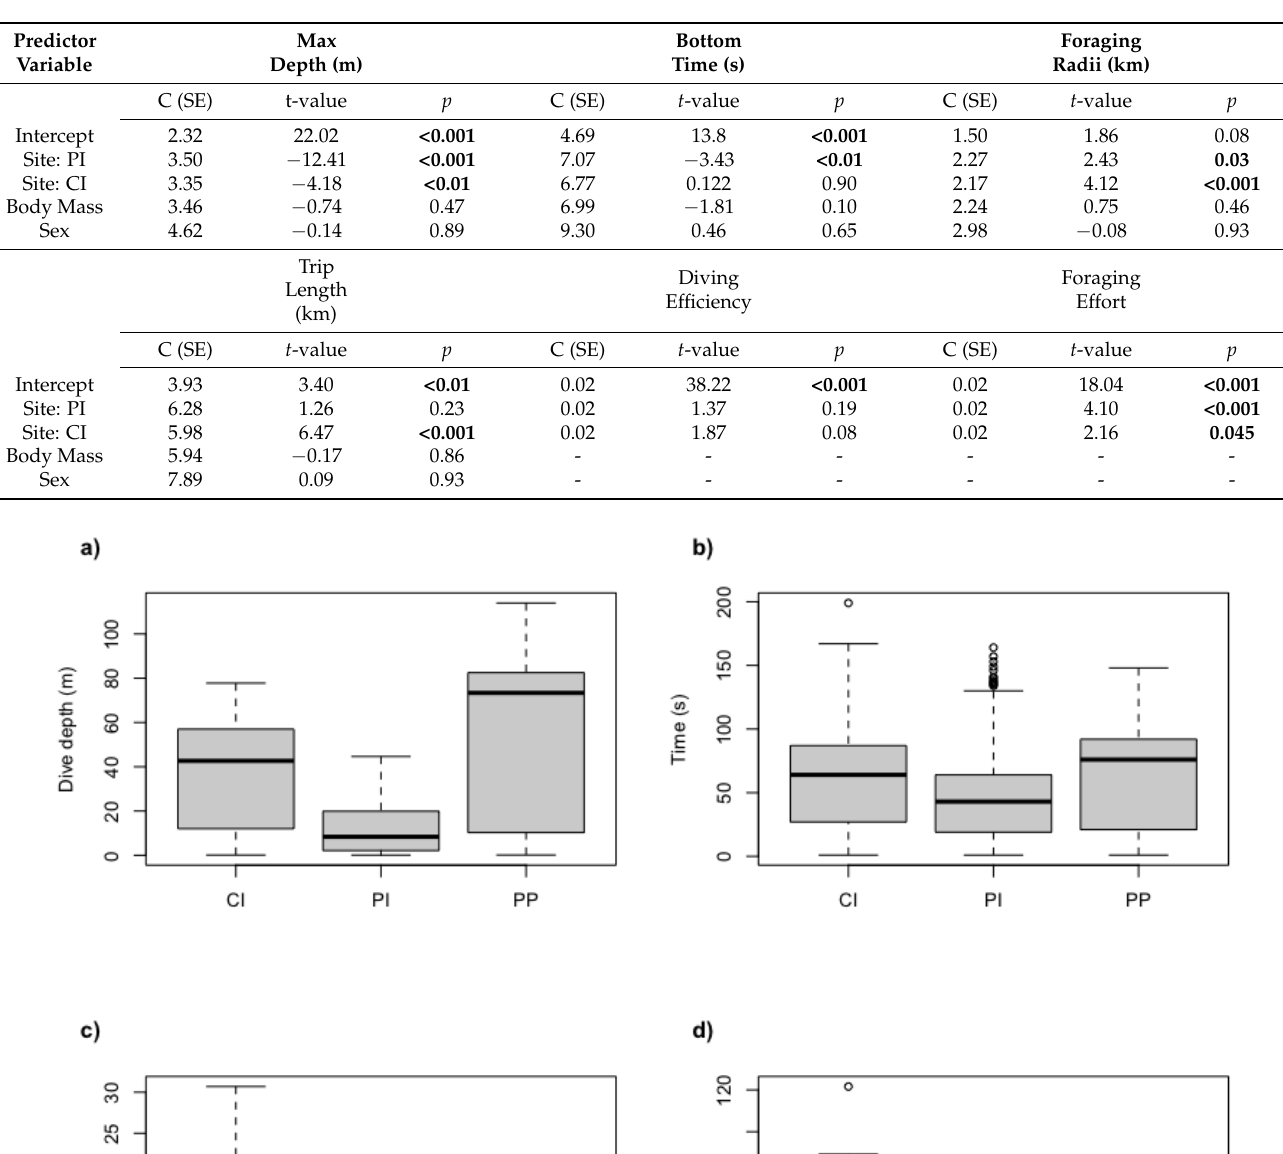
Table 2. The most parsimonious linear mixed effects models (LMM) of the maximum dive depth, bottom time, foraging radii, trip length, diving efficiency, and foraging effort of breeding yellow-eyed penguins on Stewart Island as a function of site (PI = Paterson Inlet, CI = Codfish Island) and body mass against the reference site, Port Pegasus. Bold figures indicate significant results.